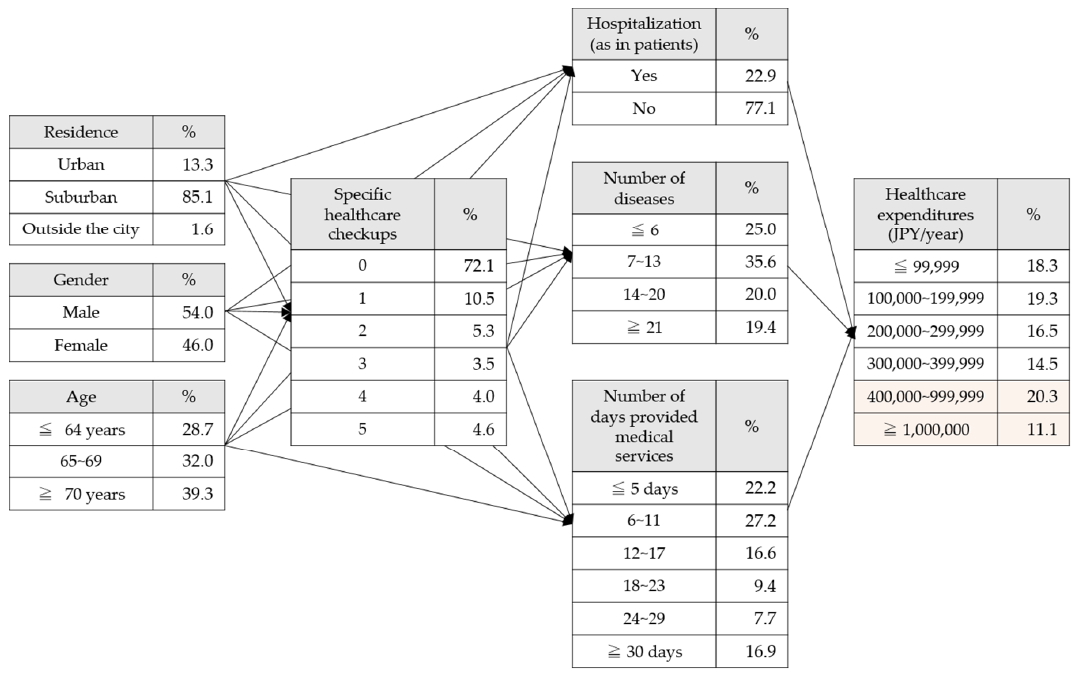
Figure 1. Bayesian network model and the observed values from the data set.